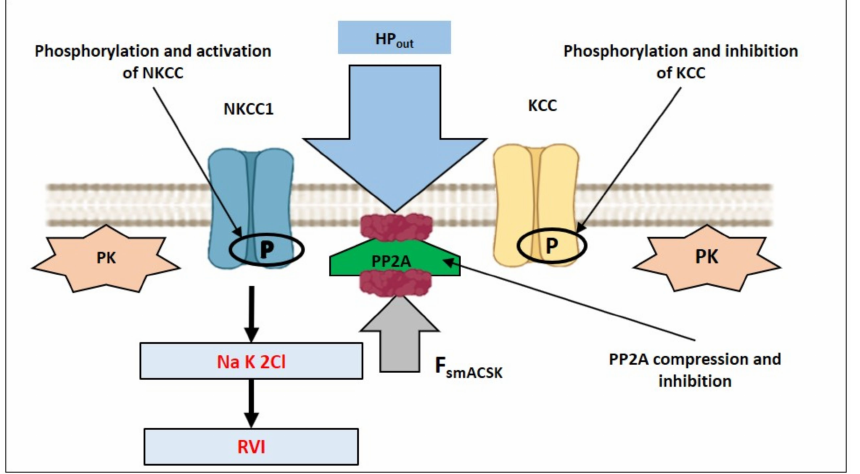
Figure 9. Illustration of hypothetical inactivation of mechanosensitive PP2A during cell shrinkage. PP2A can be compressed by both HP out and F smACSK and thus inactivated. Inactivation of PP2A would increase phosphorylation of NKCC1 by PKs that would activate NKCC1 and lead to RVI. In addition, phosphorylation of KCC by PKs would inactivate it.